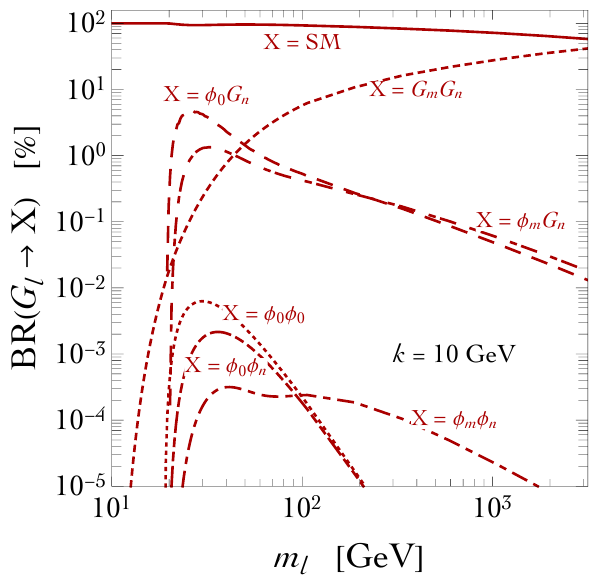
Figure 26 . Branching ratios of the graviton KK modes for k = 10 GeV and rigid boundary conditions. We take M 5 = 10